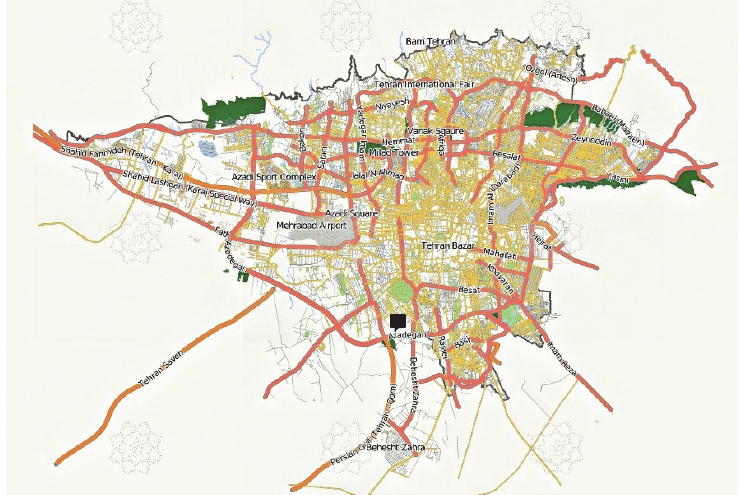
Fig. 3. Location of Tehran Central Market of Fruit and